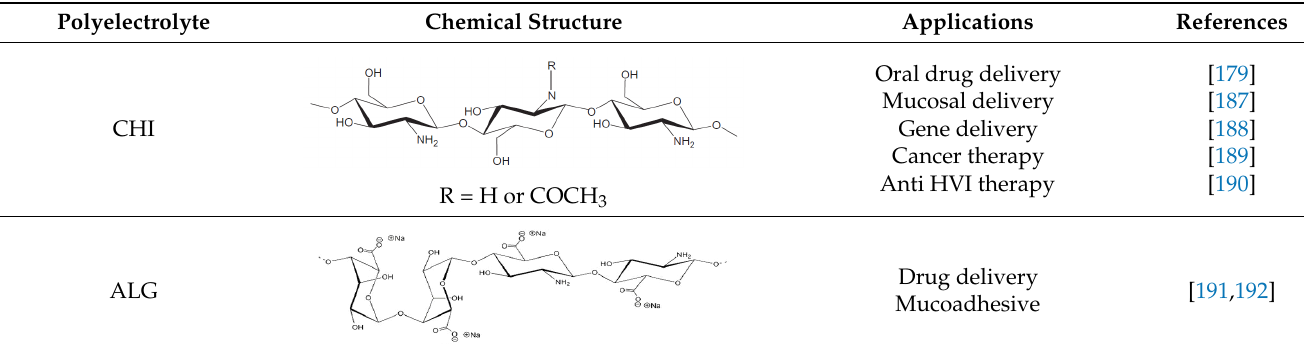
Table 7. Recently reported weak polyelectrolytes used in the design of polyelectrolyte complexes for drug delivery and biomedical research applications.